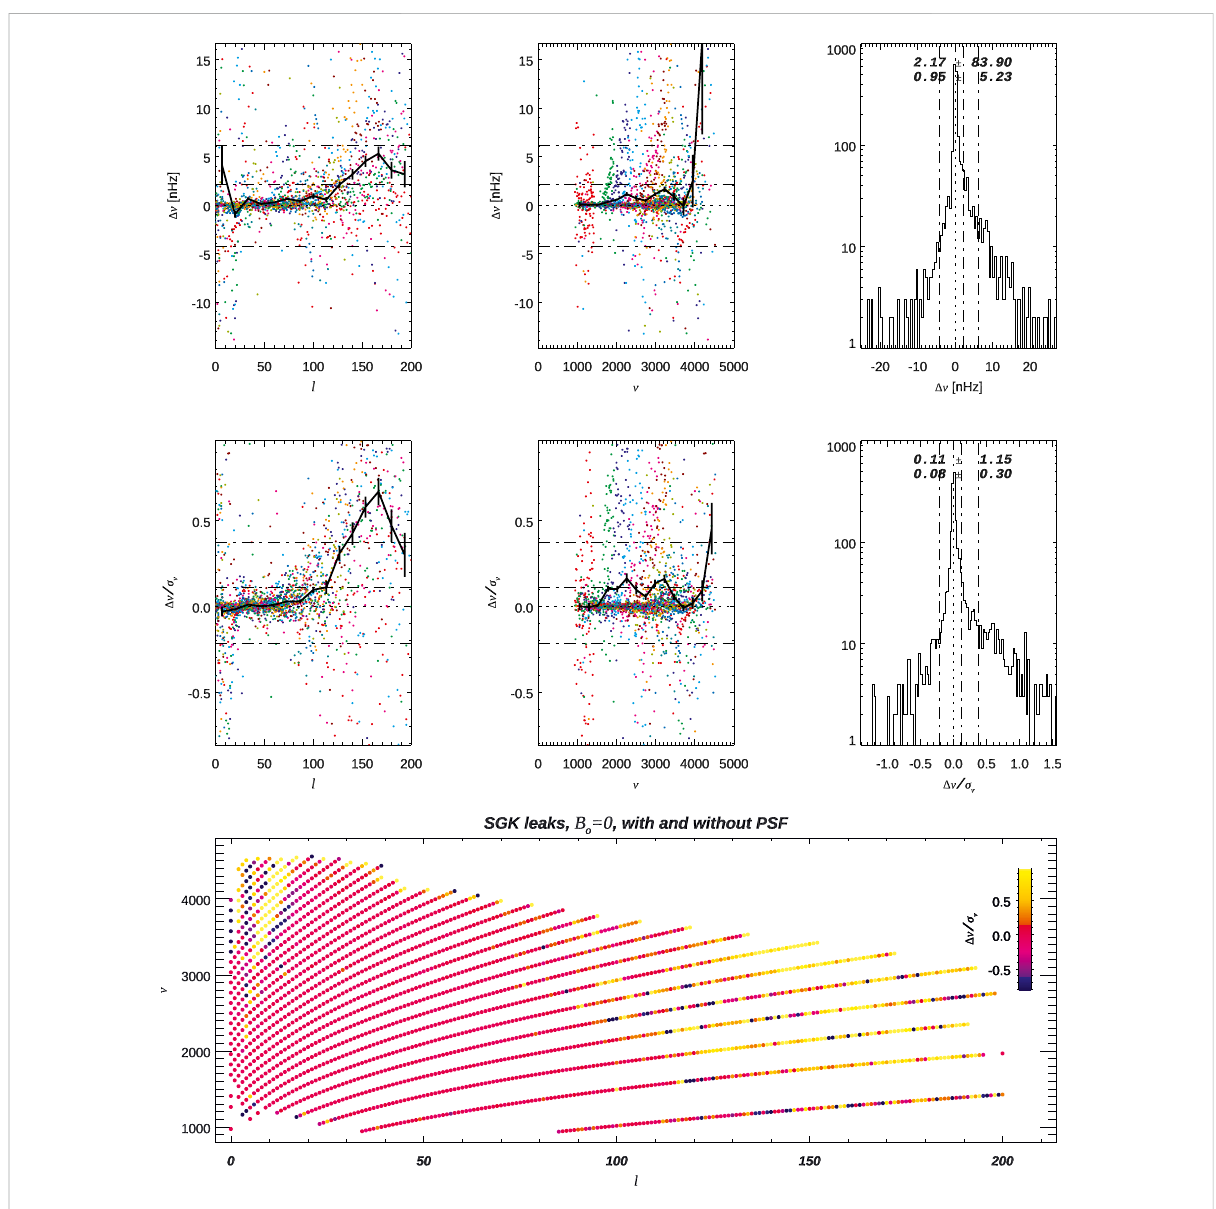
FIGURE 1 Comparison of multiplets, ] n ,  , when fi tting using a leakage matrix that either does or does not include the effect of the PSF, both for B o (cid:3) 0. Individual differences or scaled differences are plotted versus  or ] , as well as the resulting binned differences. In the top six panels, dotted lines are drawnatzero forreference,while dash-dotted linesaredrawn toindicatethemeandifferences andtheRMSaboutthemean,computed includinga 3 σ rejection. Also, for these panels, the individual color coding corresponds to the mode radial order, n . The plot ranges are set to ± 3 RMS aroundthemean,computedincludingthat3 σ rejection.Thehistogramsofthedifferencesandscaleddifferencesarealsoplottedbutwitharangeset to ± 5 RMS around the mean, computed including the 3 σ rejection. The average and RMS when using all the values, or when using that 3 σ rejection, are indicated on these panels. The bottom panel shows the distribution of the corresponding scaled differences over the  − ] plane using a gradual color coding for each